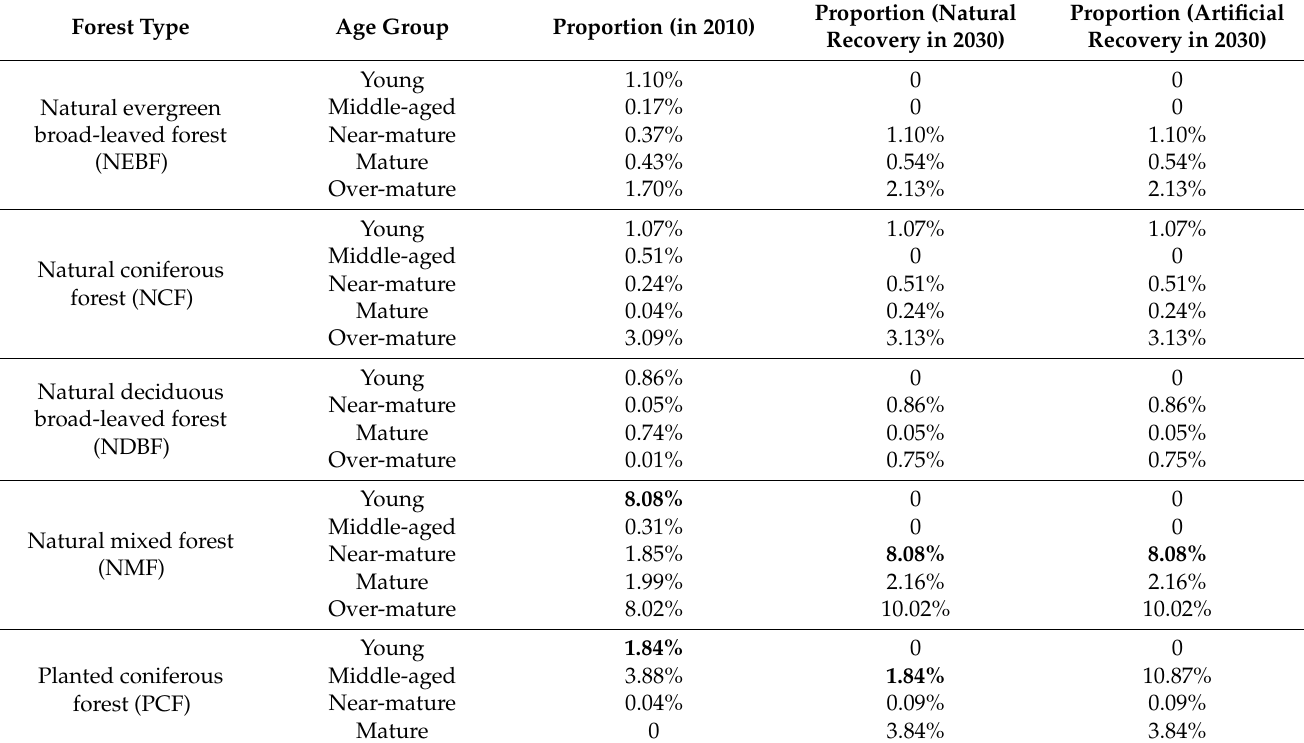
Table 4. Forest changes under natural and artificial restoration scenarios.